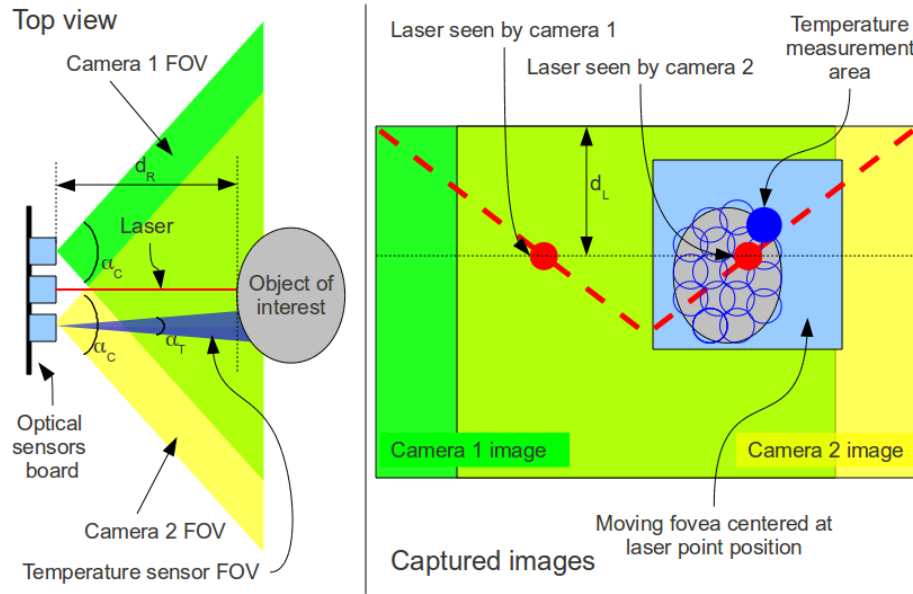
Figure 8. Optical imaging layout. Left image shows a top view diagram of the system and right image shows a captured image